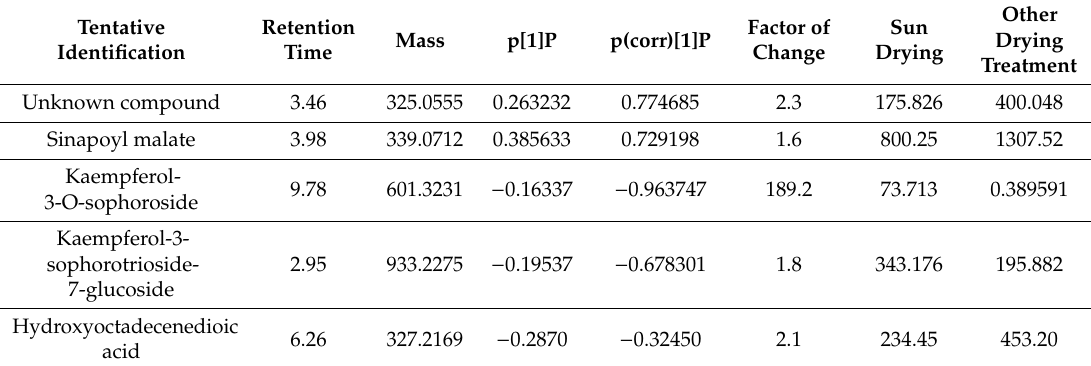
Table 7. Exact Mass / Retention Time pairs responsible for the separation of sundried Chinese cabbage and other samples that underwent solar, oven, microwave and freeze-drying